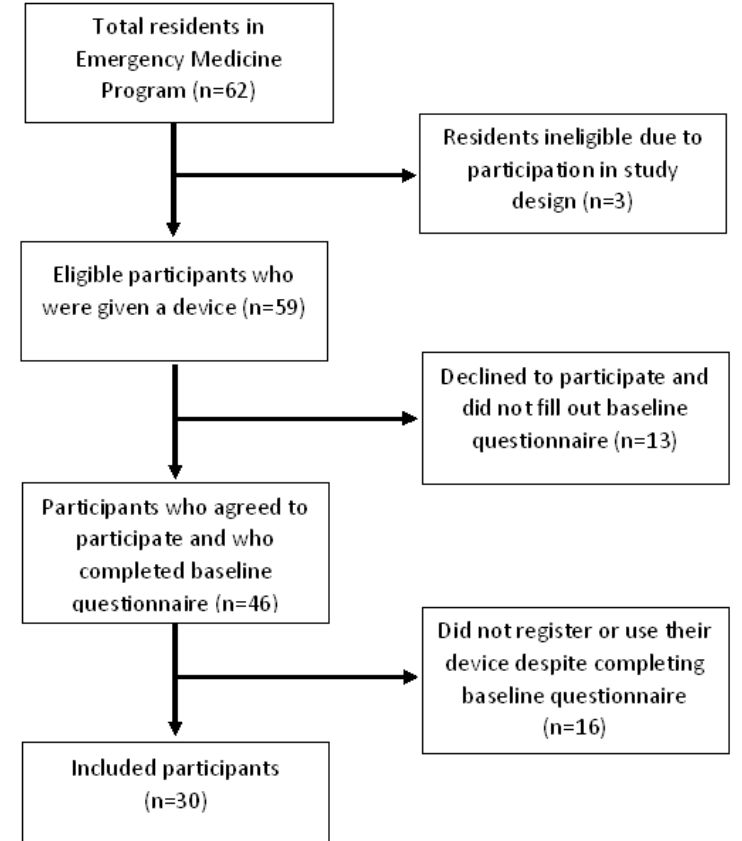
Figure 1. Flow diagram of study